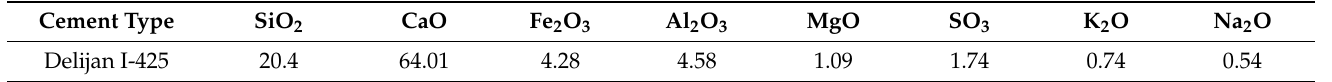
Table 2. Chemical compositions of